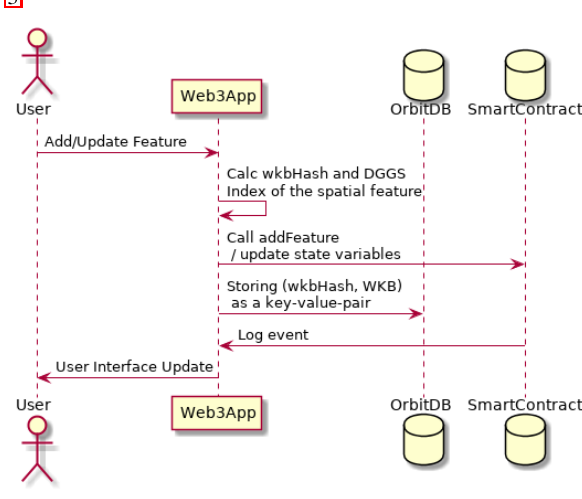
Figure 3. Geospatial dApps sequence